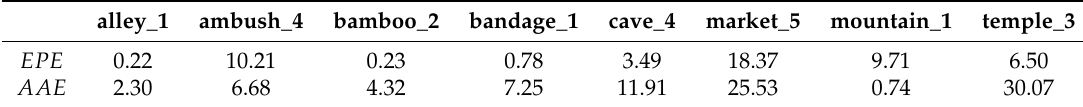
Table 3. Results obtained by PSO in the MPI-Sintel selected training